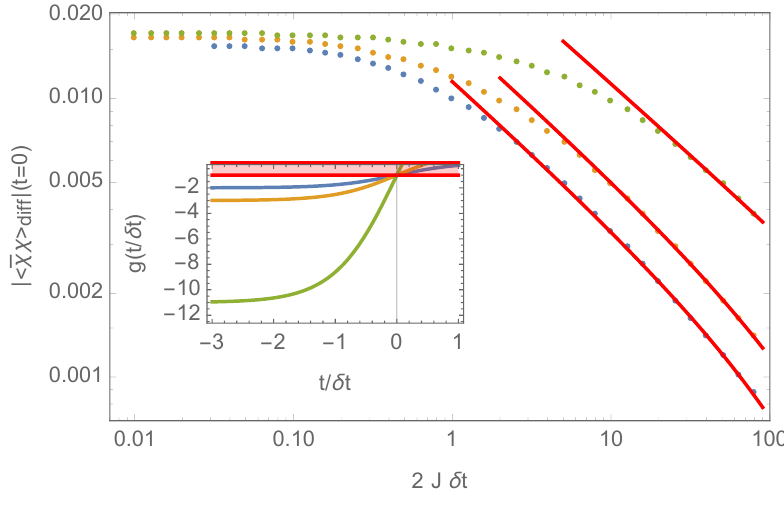
Figure 5 . Plot of h (cid:22) (cid:31)(cid:31) i di(cid:11) ( t = 0) as a function of 2 J(cid:14)t for the gapped-to-edge quench shown in the inset with g ( t ) = (cid:0) 1 + b tanh t=(cid:14)t , with b = 1(blue), 2(yellow) and 10 (green). The red curves are the best (cid:12)t by a function P + Q (2 J(cid:14)t ) (cid:0) 1 = 2 , where P = (cid:0) 0 : 0120(blue), (cid:0) 0 : 0176 (yellow), (cid:0) 0 : 0363 (green) and Q = 4 : 845 (cid:2) 10 (cid:0) 4 (blue), 5 : 807 (cid:2) 10 (cid:0) 4 (yellow), 2 : 322 (cid:2) 10 (cid:0) 4 (green). Note also that the saturation point for small (cid:14)t increases as b increases and that there is no fast scaling in the large-amplitude